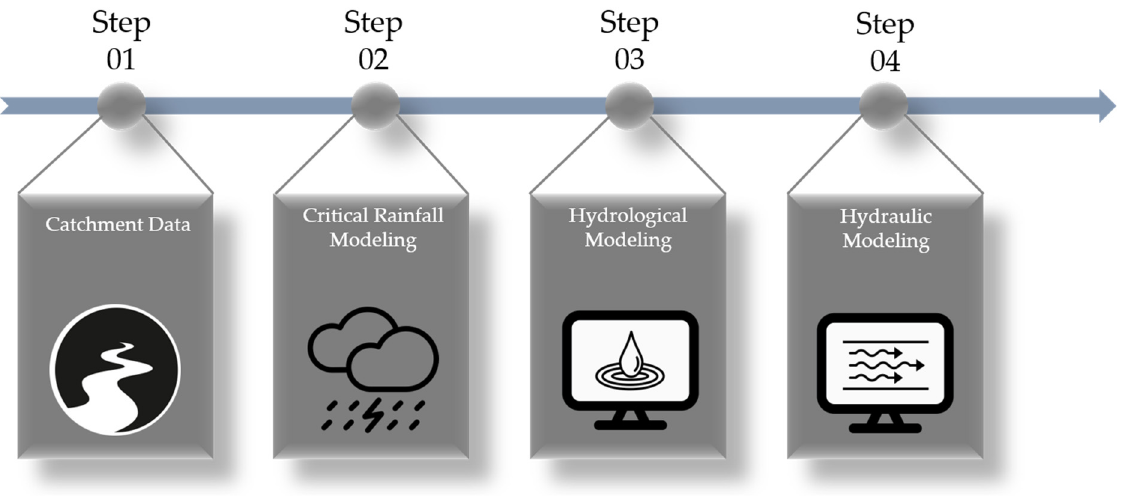
Figure 3. Steps for hydrological perception modeling.